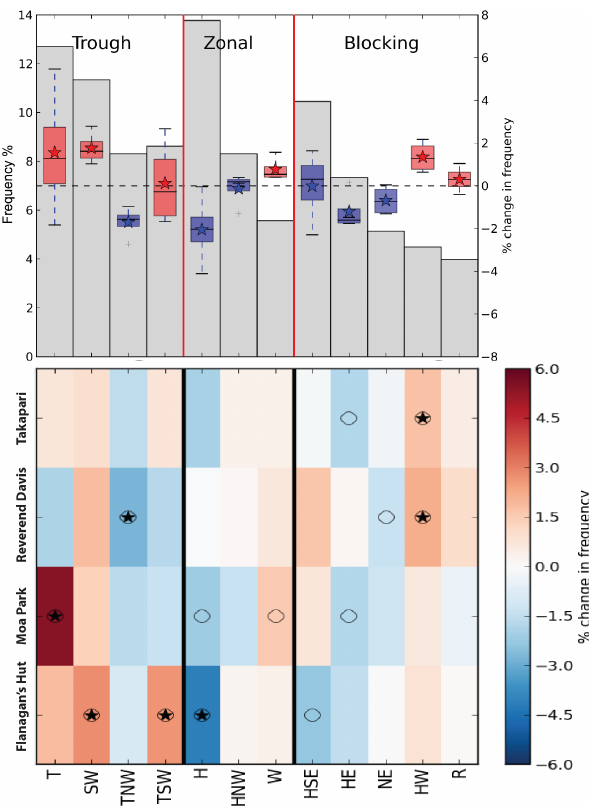
Figure 8. Top: frequency of New Zealand synoptic types ( x axis) during austral winter as determined by an ensemble composite of reconstructions from three tree ring proxy sites and the Reverend Richard Davis weather diary for 1839–1851CE. Grey bars indi- cate climatological frequencies in terms of percentage ( y axis, left); box-and-whisker plots indicate distribution of anomalies in terms of change in frequency ( y axis, right) indicated by the ensemble re- construction. The black horizontal line in each box is the median bound by the 25th and 75th percentile, while whiskers are 5th and 95th percentile. Synoptic type abbreviations follow Kidson (2000; see Supplement for full details). Bottom: heat map of New Zealand synoptic type ( x axis) frequency changes with respect to climatol- ogy for individual site members ( y axis) of the ensemble composite for 1839–1851CE. Significance of synoptic type frequency changes was assessed using a Monte Carlo approach. A total of 10000 sim- ulations of synoptic type evolution were realized based on Markov chains constrained by the observed frequency and transition prob- abilities between Kidson’s (2000) synoptic types observed during the modern reanalysis era (1972–2012). Circles and stars represent anomalies significant at the 90th and 95th level, respectively. Fig- ures generated using the Past Interpretation of Climate Tool (PICT) courtesy of National Institute of Water and Atmospheric Research (NIWA). See Lorrey (2014) and http://pict.niwa.co.nz for details.